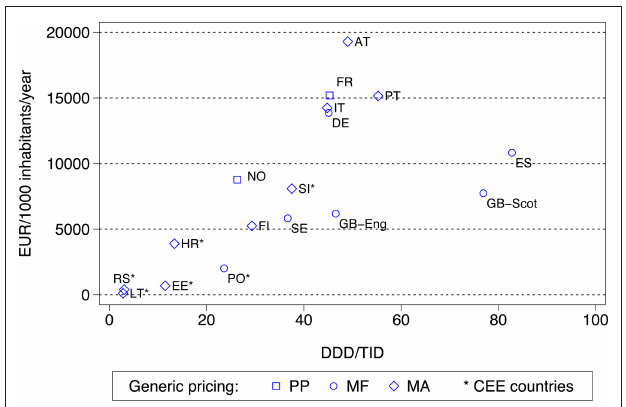
FIGuRE 3 | utilization (DDD/TID) and overall expenditure (€/1000 inhabitants/year) for PPIs among European countries in 2007 (Italy 2008, Serbia 2008). Standard EU country abbreviations have been used. ES = Catalonia. Republic of Ireland not included as the GMS population has greater morbidity than the general population.